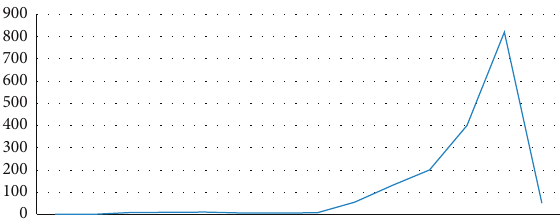
Figure 7: Article distribution by years for state-of-the-art review